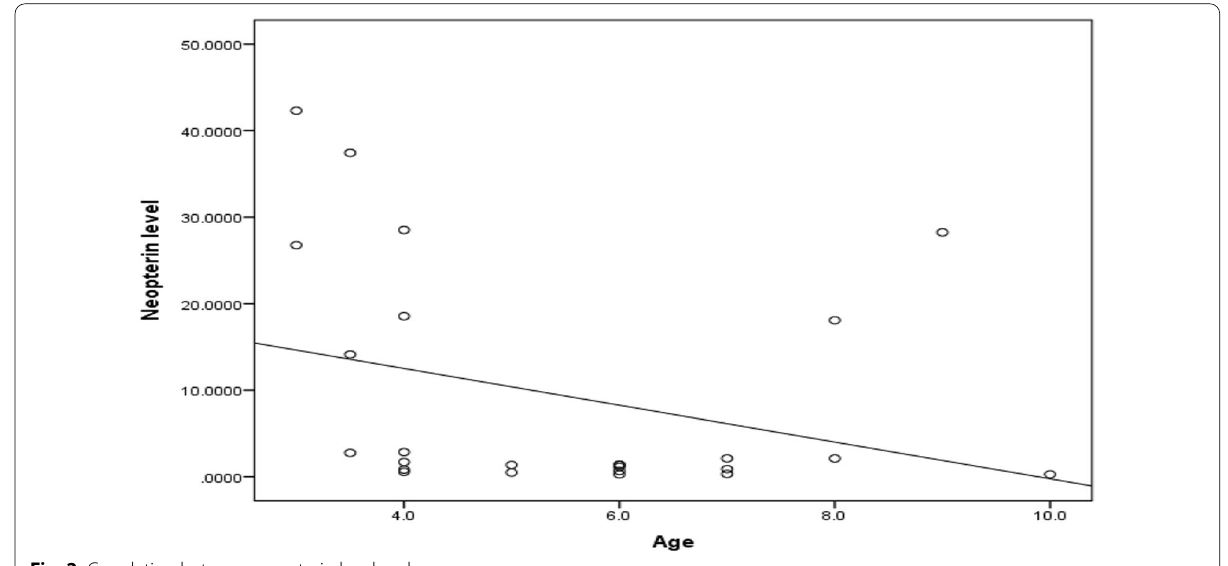
Fig. 2 Correlation between neopterin level and age